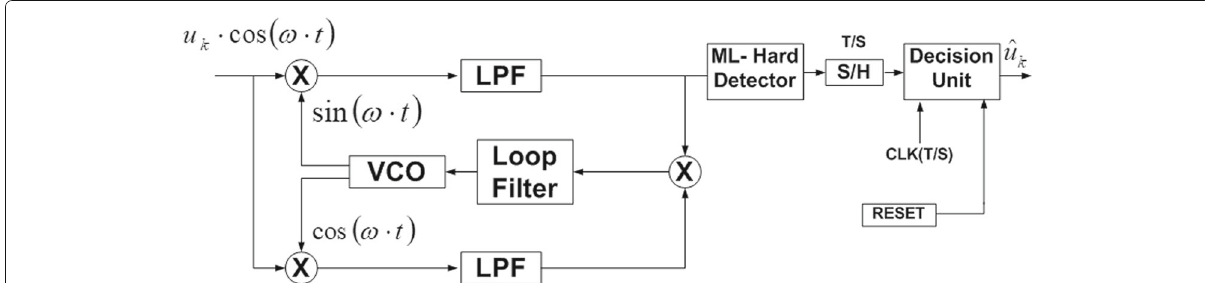
Fig. 6 The Costas loop as our reference oversampling data recovery system. This loop and the proposed recovery system have the same modulation at the ML trigger’s input